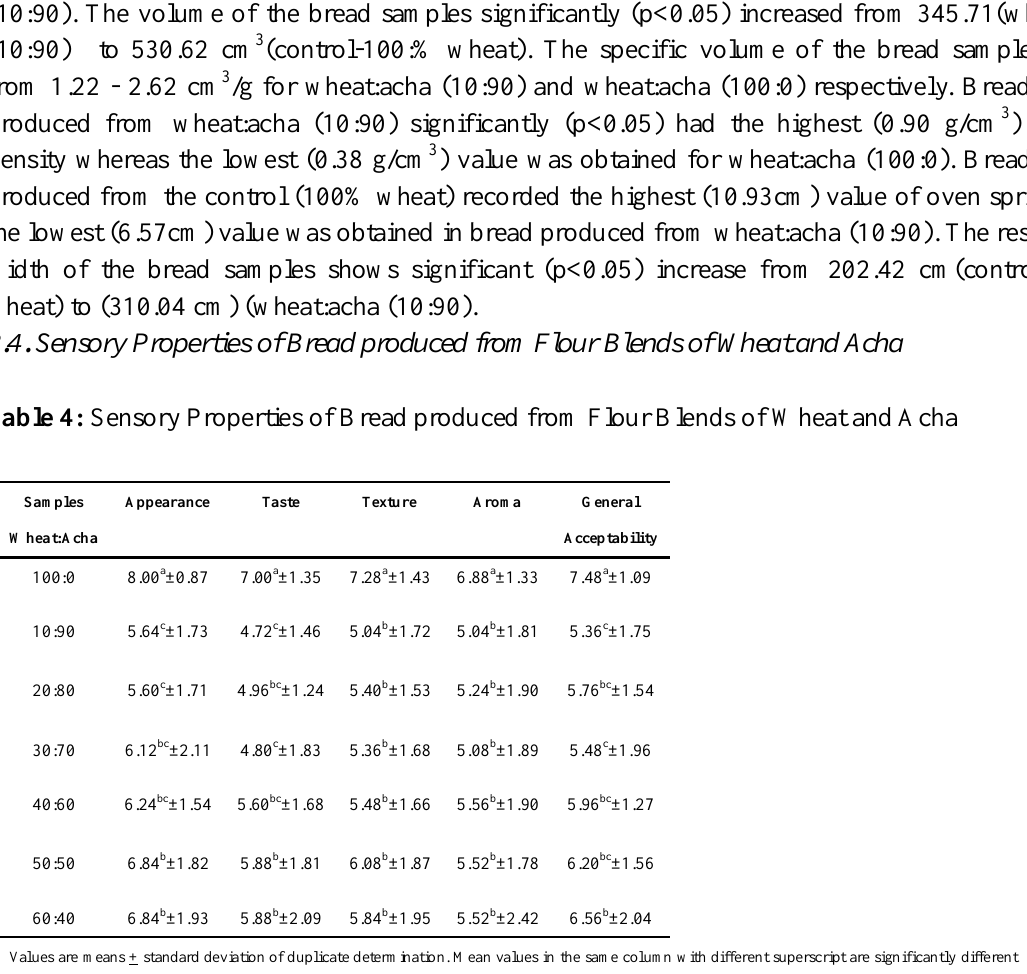
Values are means + standard deviation of duplicate determination. Mean values in the same column with different superscript are significantly different (p<0.05) Table 3 shows the physical properties of bread produced from flour blends of wheat and acha.